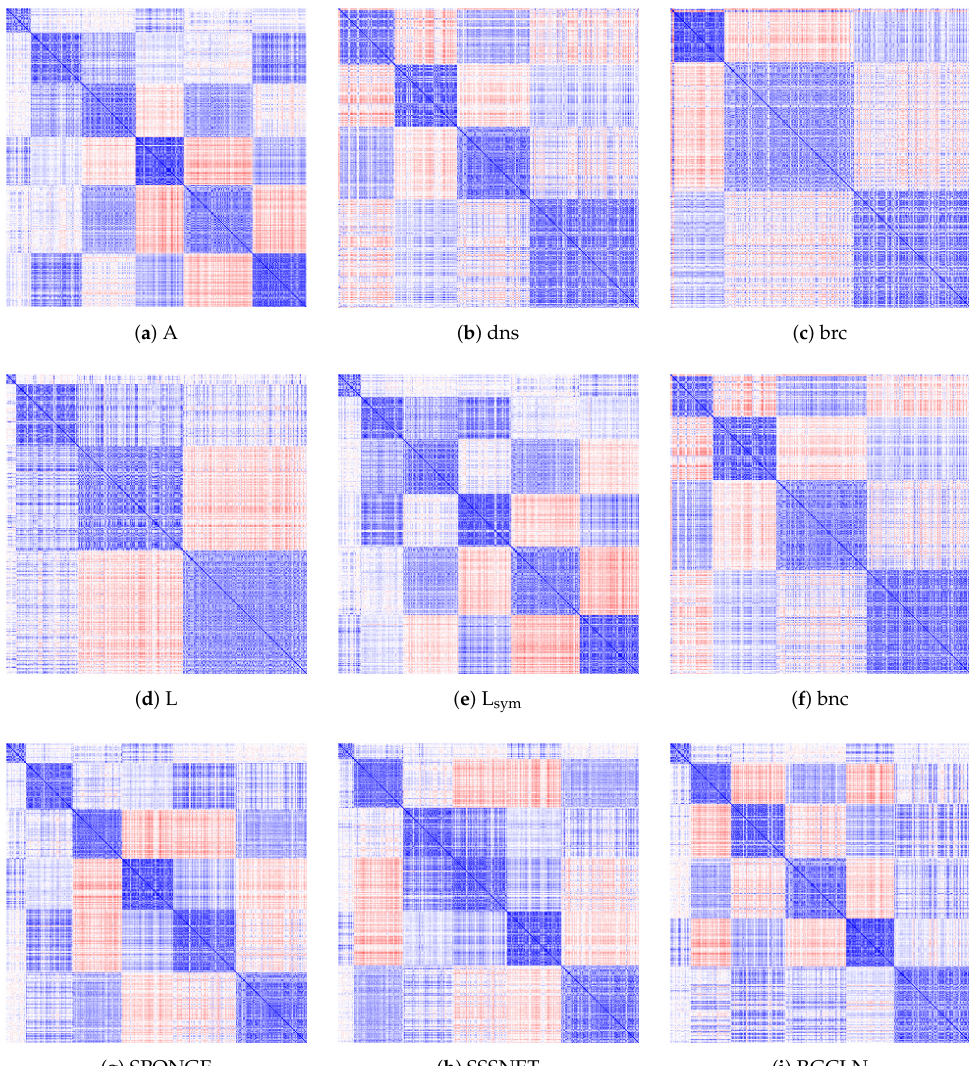
Figure 2. Sorted adjacency matrix of Rainfall dataset (k = 6).